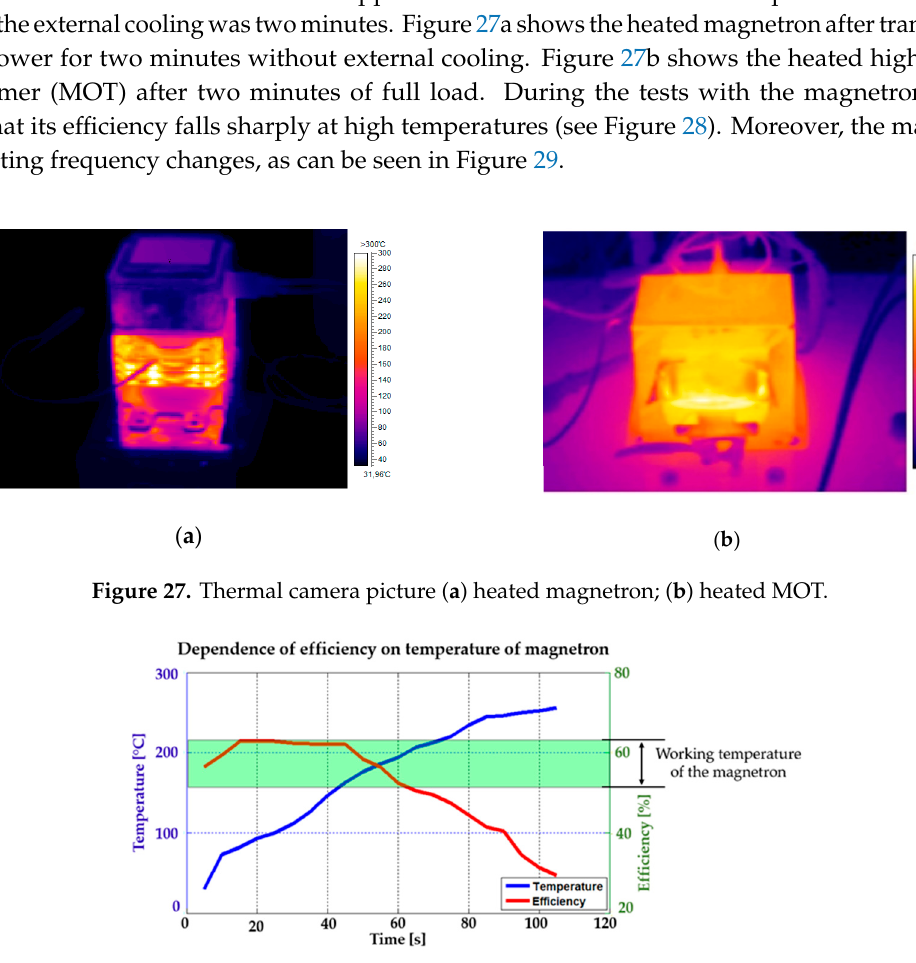
Figure 28. Efficiency against the Magnetron temperature.